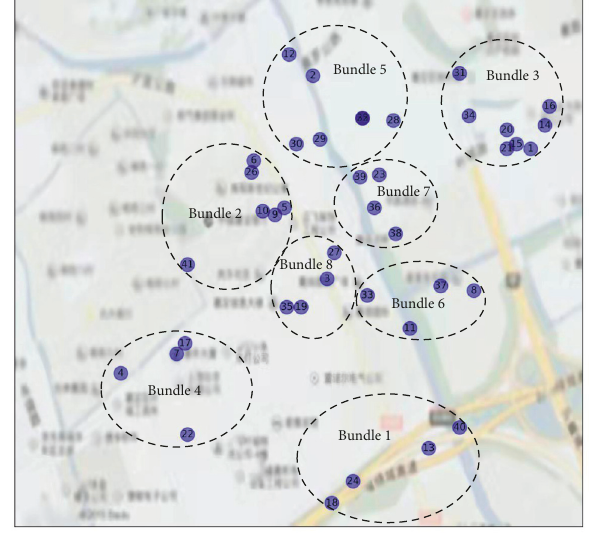
Figure 8: Spatial distribution of 41 orders and 8 clustered